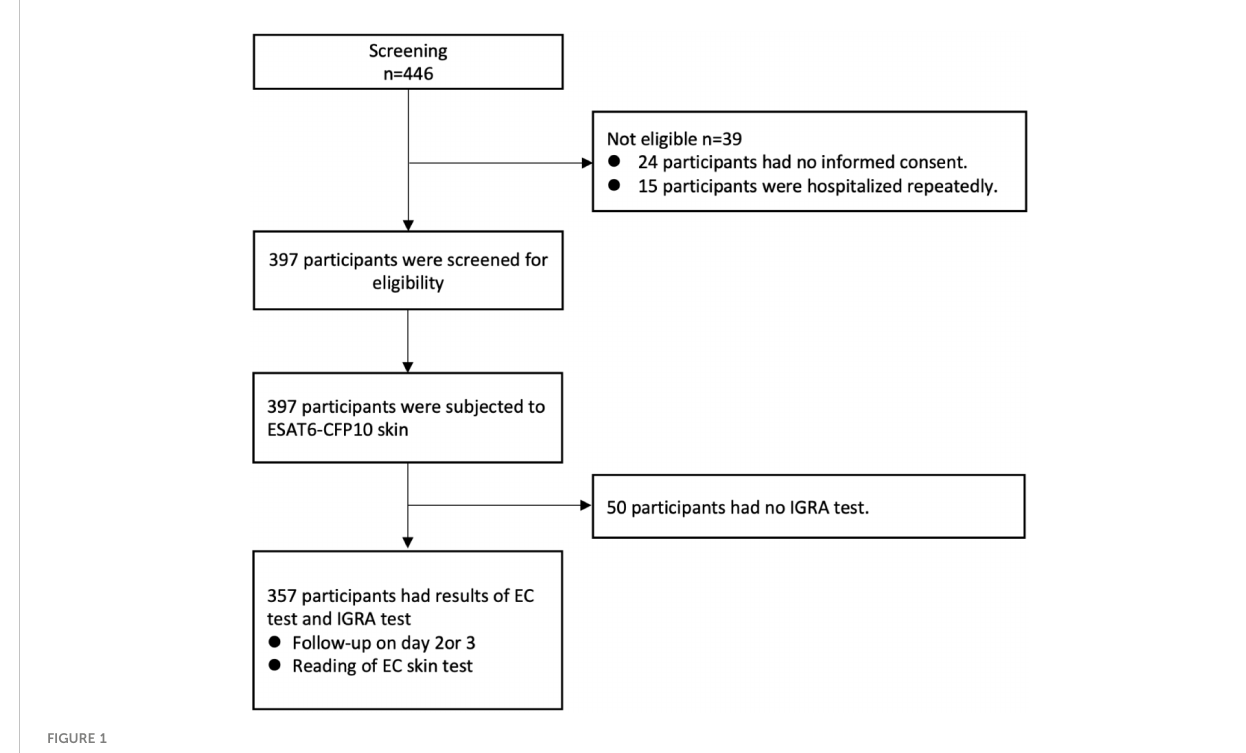
FIGURE 1 Study fl ow